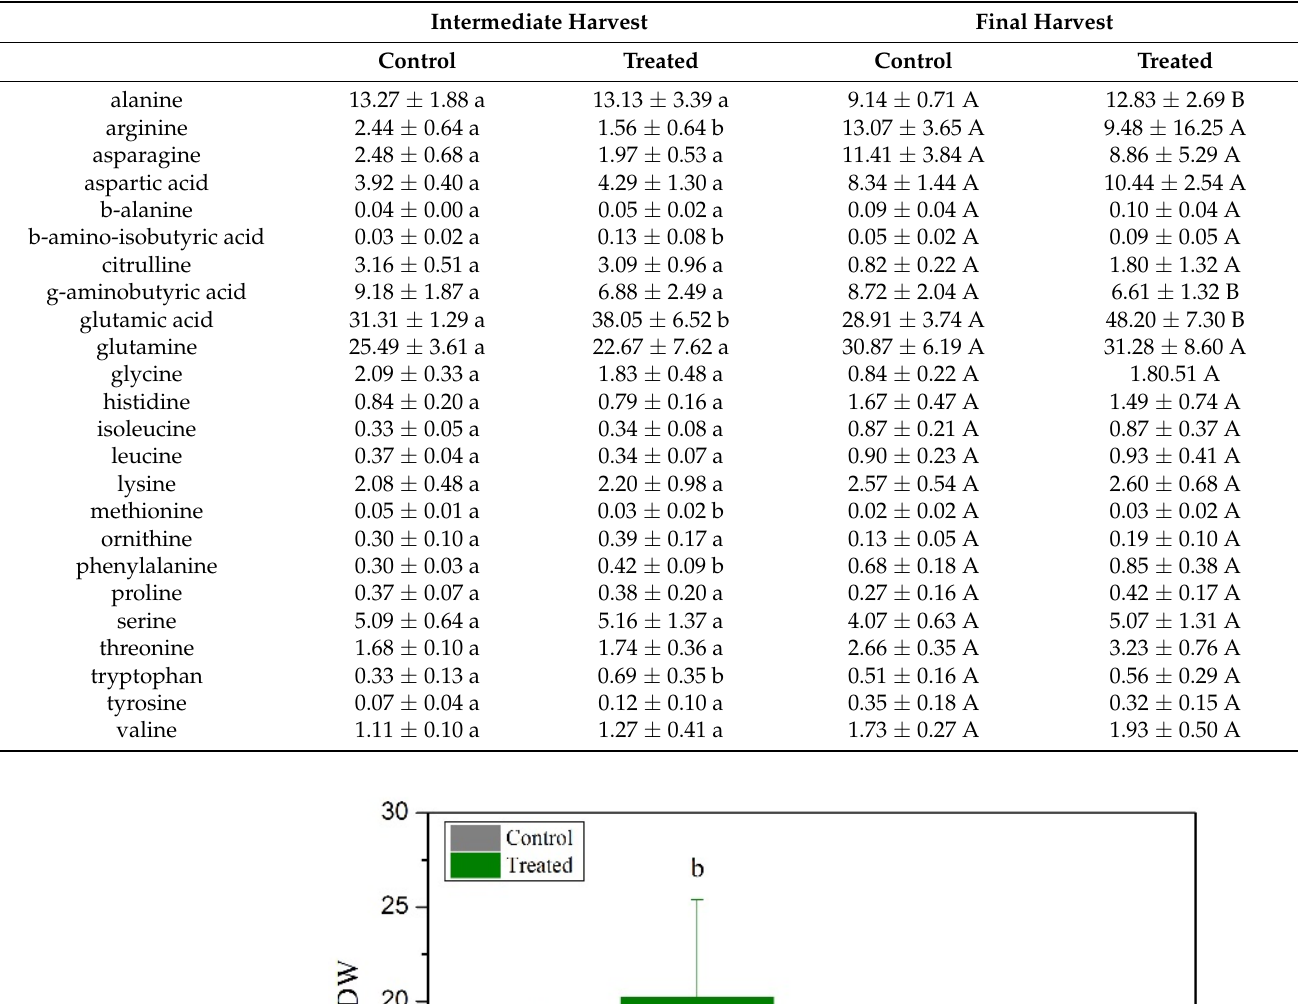
Table 4. Individual amino acid concentrations in basil leaves for the various salinity treatments at the intermediate and final harvests, expressed as mg kg − 1 FW. Different letters indicate statistically significant differences between treatments at each harvest (small letters refer to the intermediate and capital ones to the final harvest, p < 0.05). Values are expressed as mean ± standard deviation ( n = 5).